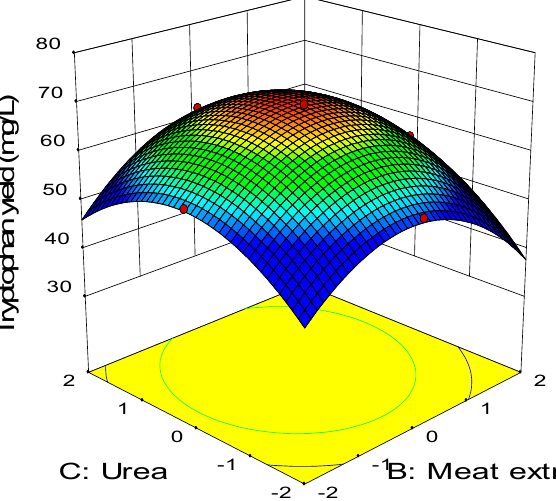
Figure 6. Response surface of tryptophan production by P. acidilactici TP-6 as a function of meat extract and urea.